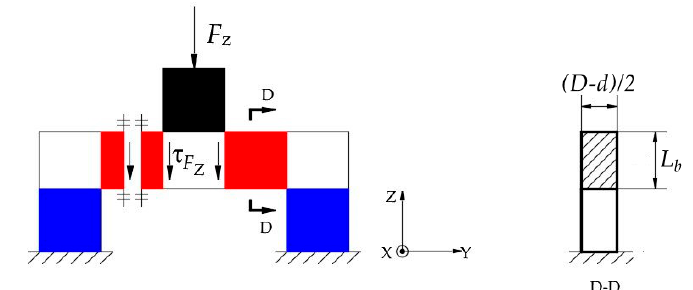
Figure 10. Basic constitutional unit of cylinder-shaped elastic structural body.